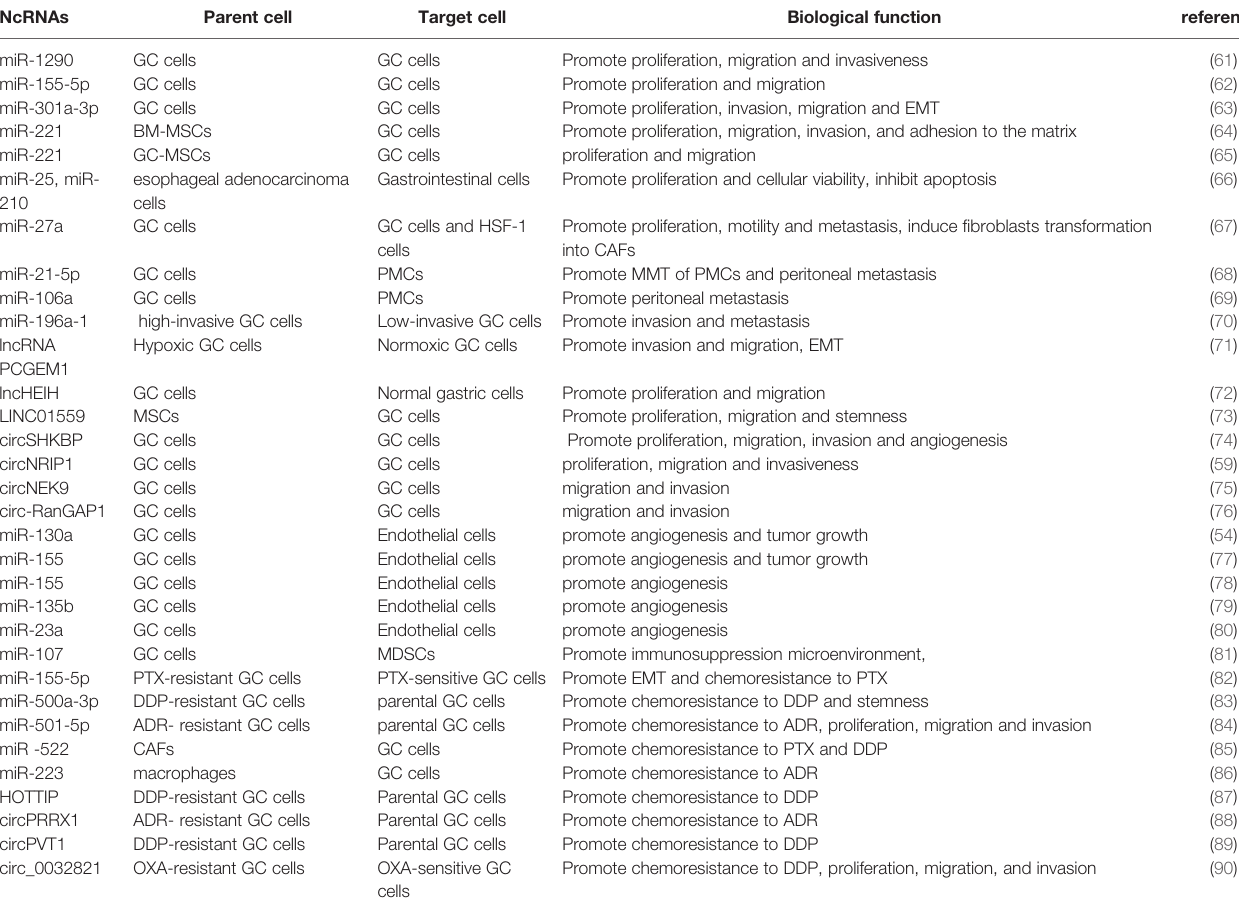
TABLE 1 | The biological function of exosomal ncRNAs in